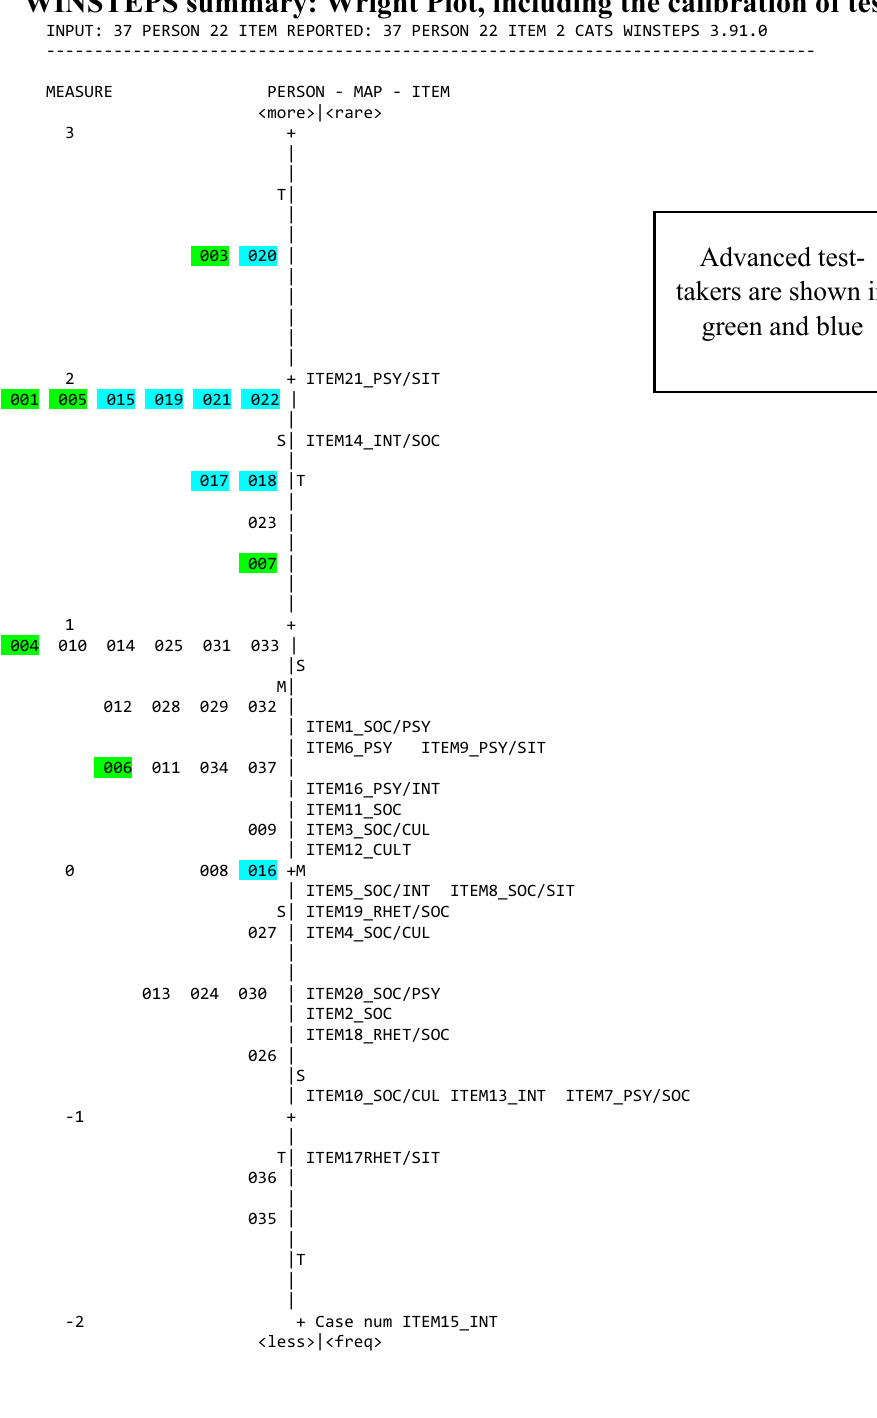
WINSTEPS summary: Wright Plot, including the calibration of test items